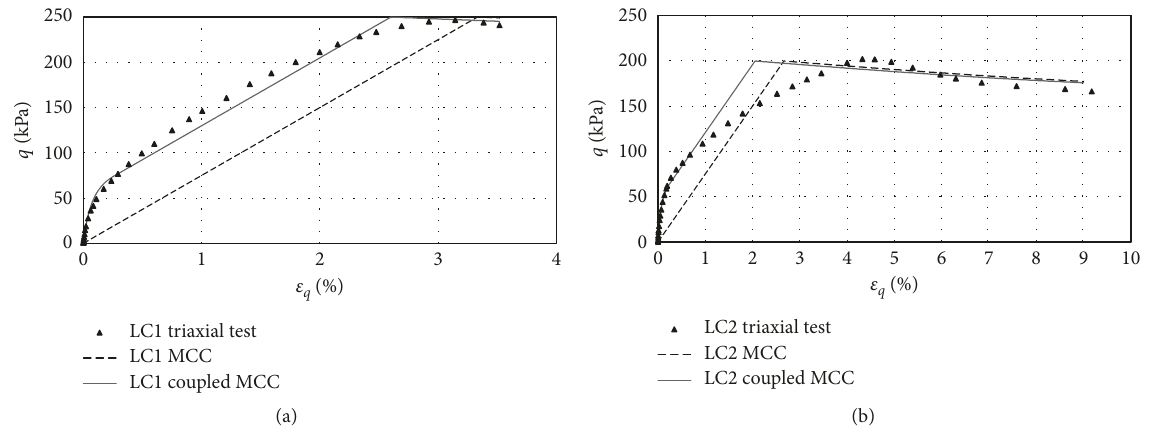
Figure 7: Variations of deviatoric stress in London Clay based on data from Jardine et al. [2].